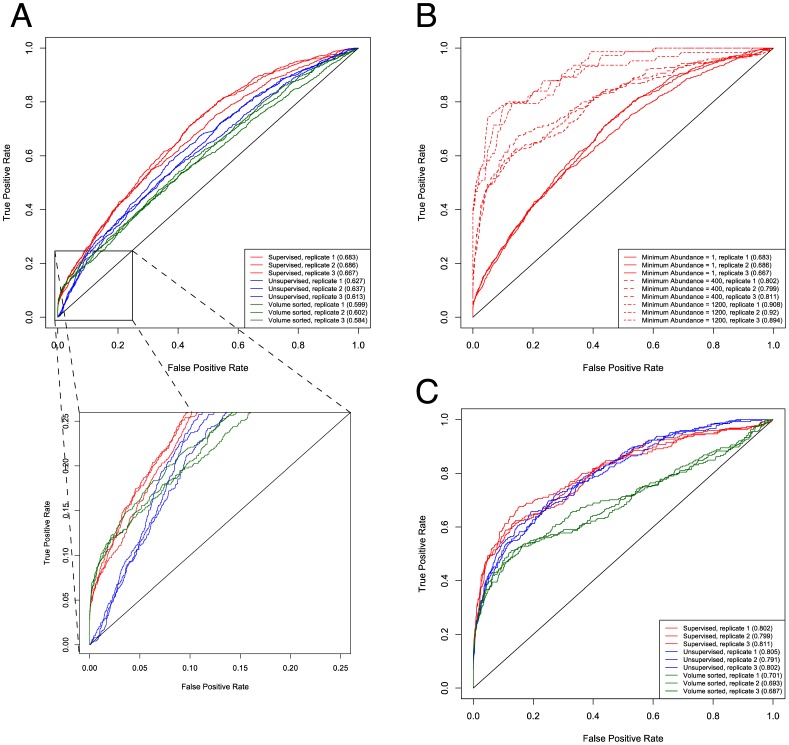
ROC curves comparing a supervised learning (red), unsupervised learning (blue) and a naïve classifier based on peak volume (green) for triplicate analysis of lung HS.ROC curves were calculated for triplicate LC/MS runs acquired using lung HS. Area under the ROC curve (ROC) is indicated in parentheses. (A) Comparison of supervised, unsupervised, and volume sorting-based scoring methods in the absence of a minimum abundance noise filtering threshold. An expanded range is shown below. (B) Supervised scoring results compared at different levels of minimum abundance thresholding, where minimum abundance of 1 is identical to (A). (C) Comparison of all scoring methods using minimum abundance threshold of 400.